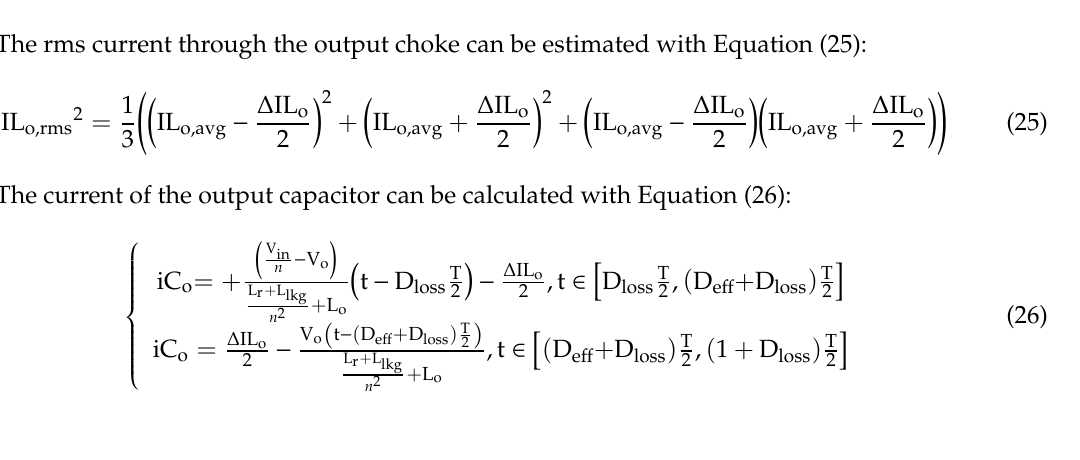
Figure 5. Input capacitor, output choke and output capacitor currents of a simplified model of a PSFB converter.